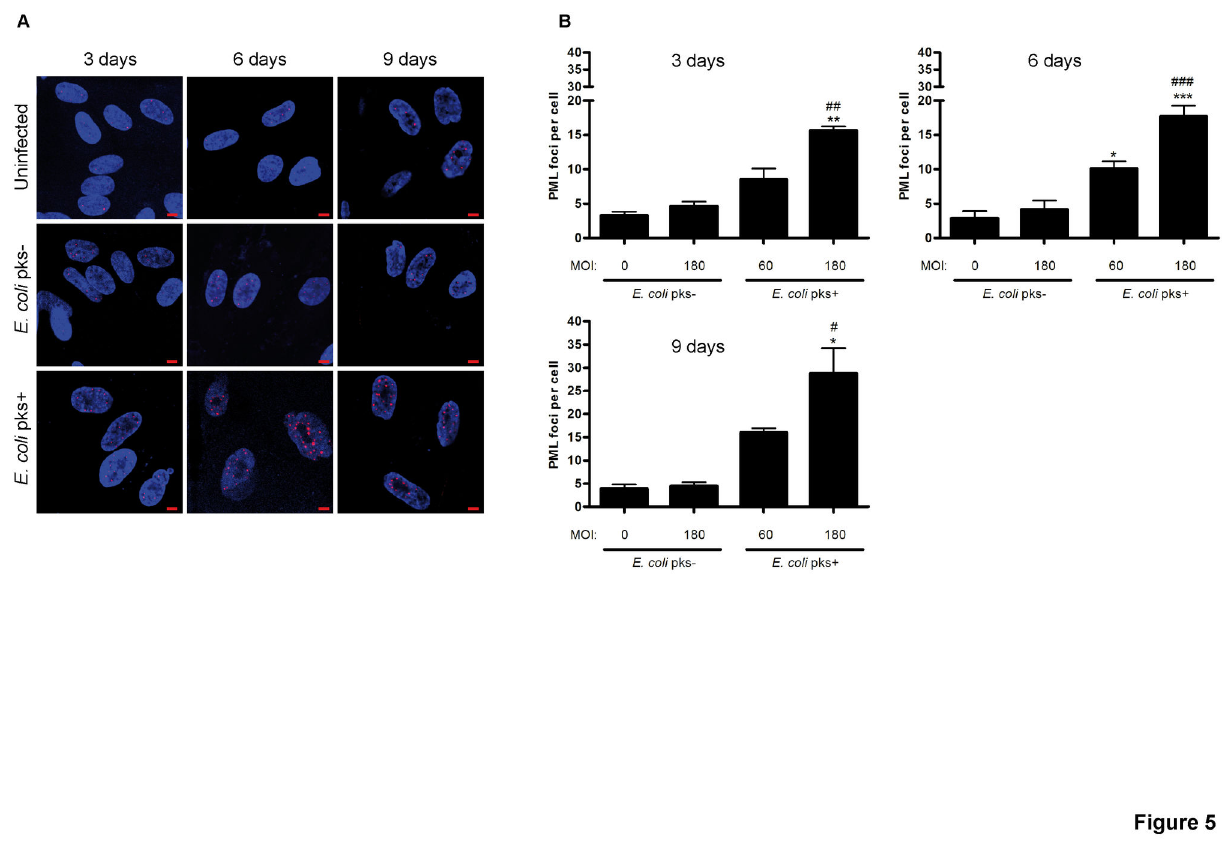
Figure 5. Increased PML nuclear bodies in IMR-90 cells infected with pks + E. coli. (A) Cells were examined for DNA (blue) and PML protein (red) 3, 6 or 9 days after infection. Pictures of uninfected and MOI 180-infected cells are shown, scale bars = 10µm. (B) PML foci in 30-100 nuclei for each condition were counted by a blinded observer. Results represent the mean and SEM of three independent experiments, one-way ANOVA with Bonferroni’s multiple comparison test; *P<0.05, **P<0.01, ***P<0.001 comparing infected and uninfected groups; #P<0.05, # #P<0.01, # # #P<0.001 comparing pks + and pks - groups. doi: